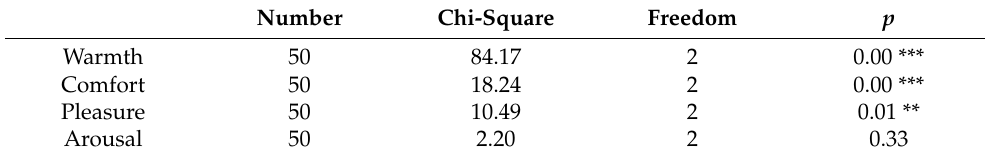
Table 3. Friedman test of perception scale.